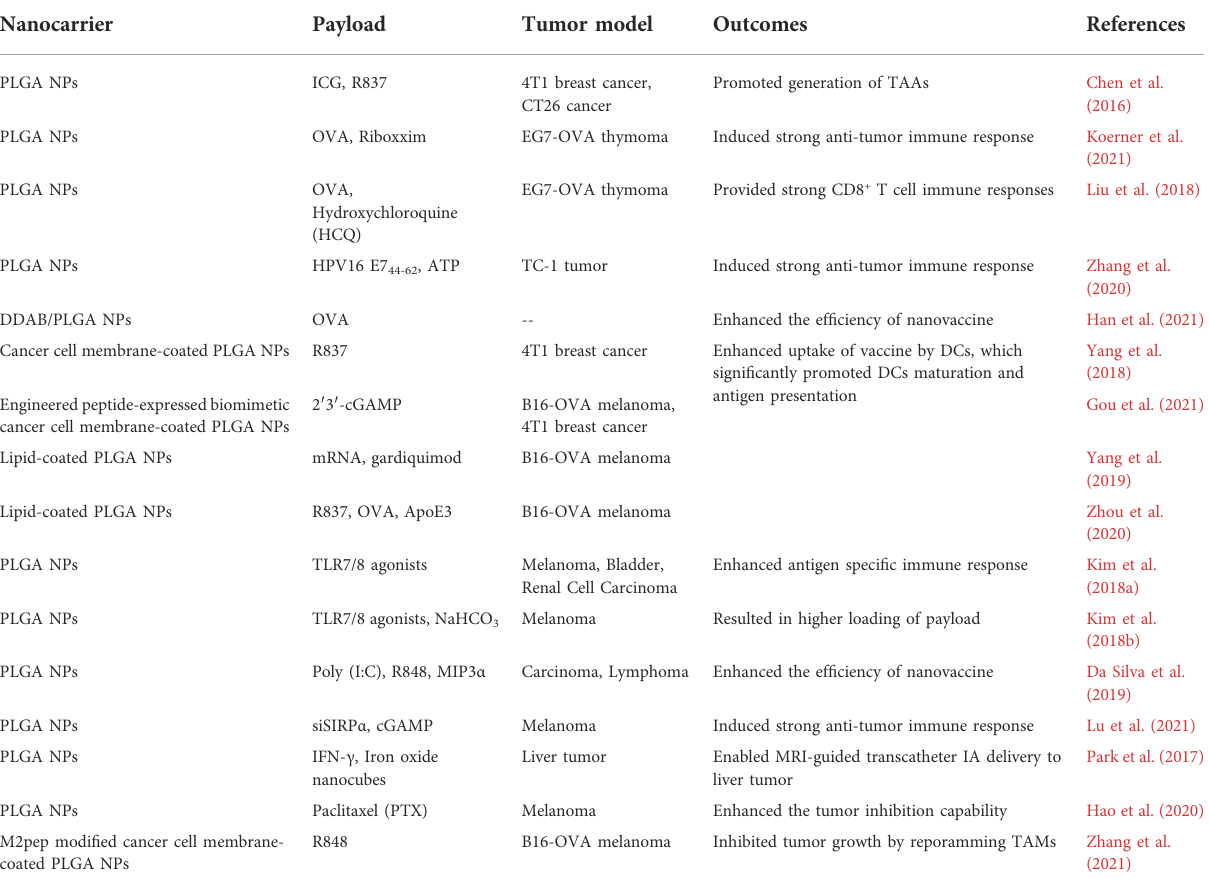
TABLE 1 PLGA-based nanoparticles used as delivery systems in cancer